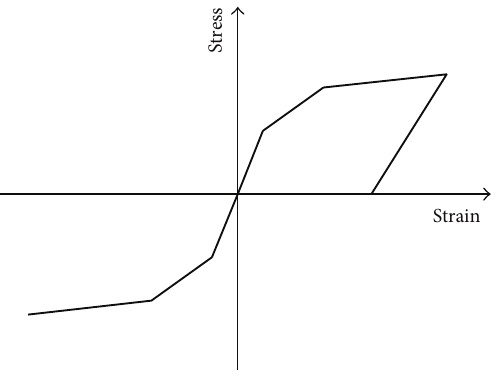
Figure 17: Stress-strain relationship of